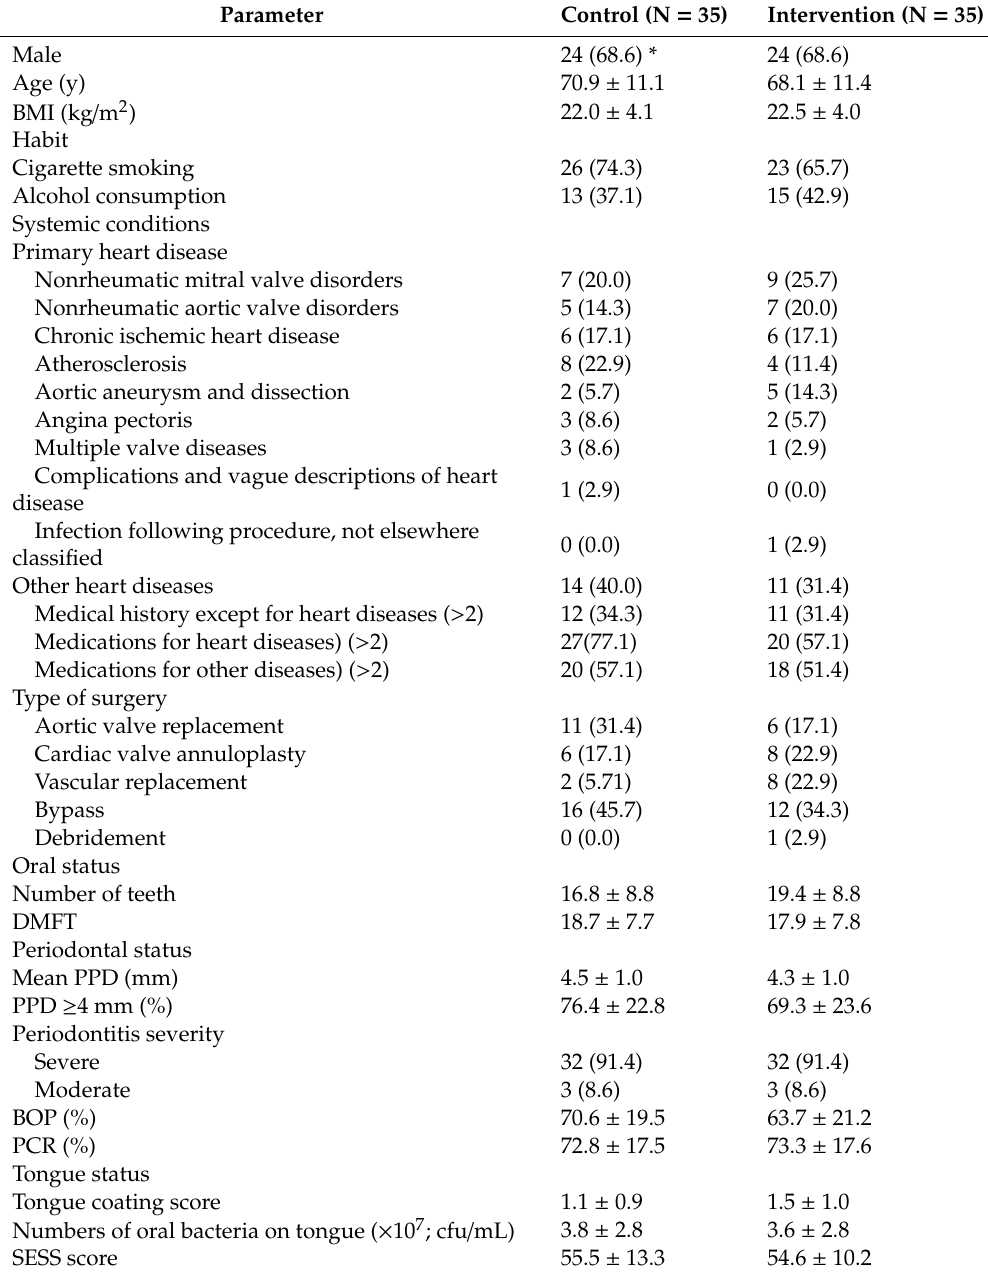
Table 2. Baseline characteristics of